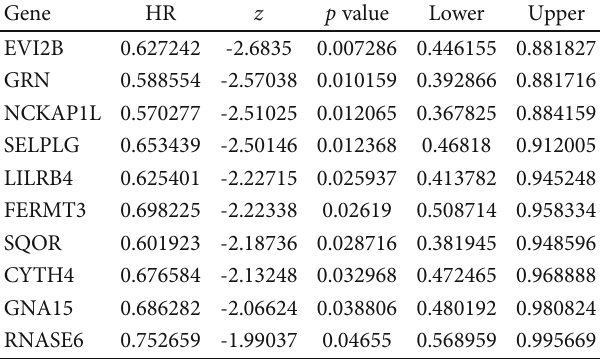
Table 2: 10 prognostic genes for overall survival of OS patients assessed by univariate regression